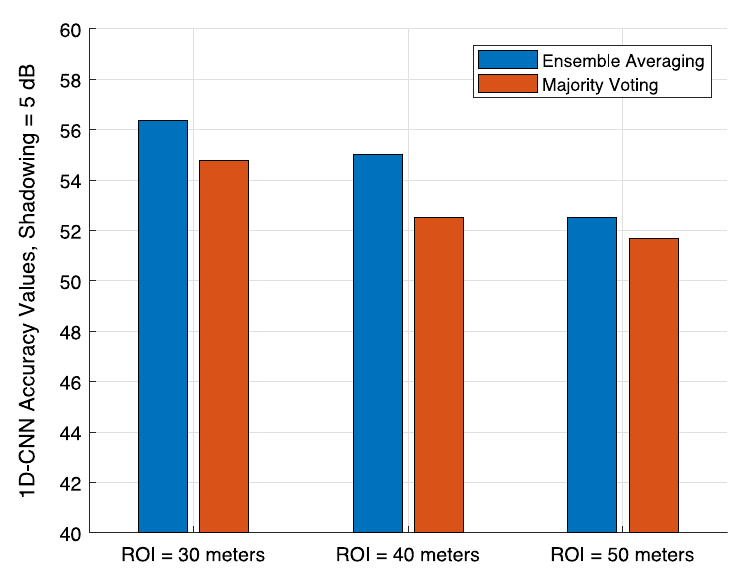
Fig. 8 Accuracies of 1D CNN at 5 dB